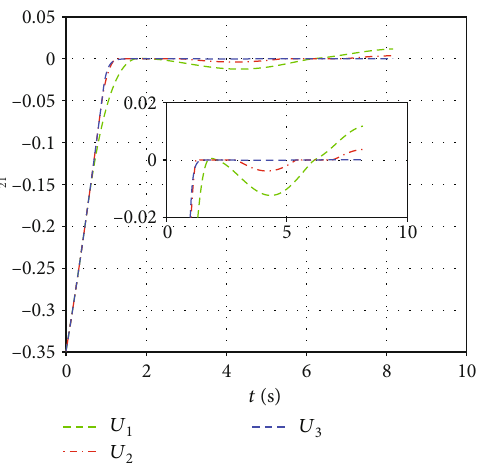
Figure 44: Dynamic error surfaces s